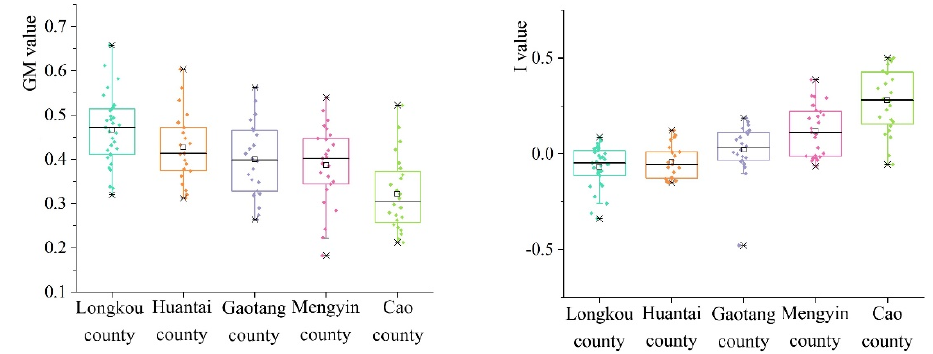
Figure 7. The mean statistics of the proportion of rural residential land types in different areas. Figure 7. Statistics on the internal structure characteristics of rural residential land in different areas.